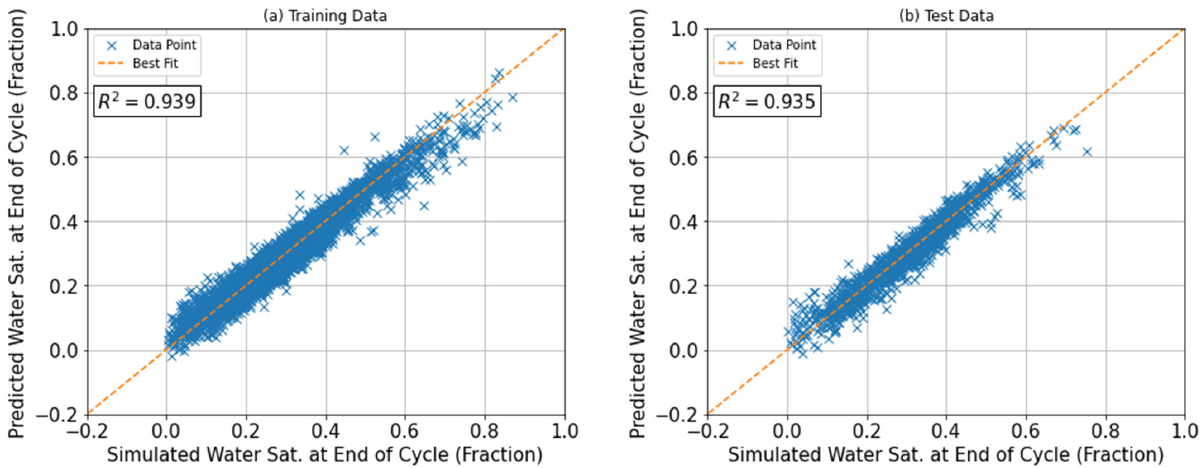
Figure 15. Predicted and simulated plot of ( a ) training data and ( b ) testing data for reservoir water saturation at the end of the cycle—polynomial regression model.